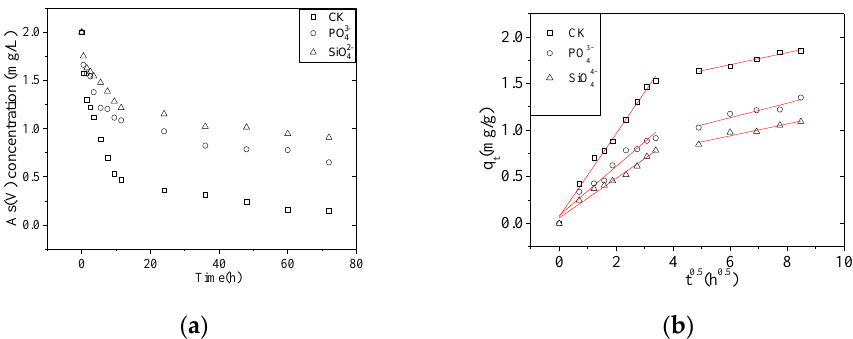
Figure 6. Effect of single interfering ions on As(V) adsorption. ( a ) Effect of single coexisting ions on Figure 6. E ff ect of single interfering ions on As(V) adsorption. ( a ) E ff ect of single coexisting ions on As(V) removal as a function of time. ( b ) Intraparticle diffusion model fit for the As (V) removal by As(V) removal as a function of time. ( b ) Intraparticle di ff usion model fit for the As (V) removal by NZVI/AC in the presence of single coexisting ions (conditions: C 0 = 2.0 mg/L, 150 rpm, 20 × 40 mesh NZVI / AC in the presence of single coexisting ions (conditions: C 0 = 2.0 mg / L, 150 rpm, 20 × 40 mesh particle size, t = 72 h, T = 298 K, adsorbent dosage = 1.5 g/L, pH = 6.5, coexisting ions = PO 43− or SiO 42− ). particle size, t = 72 h, T = 298 K, adsorbent dosage = 1.5 g / L, pH = 6.5, coexisting ions = PO 3 CK, control in the absence of interfering ions. CK, control in the absence of interfering ions.